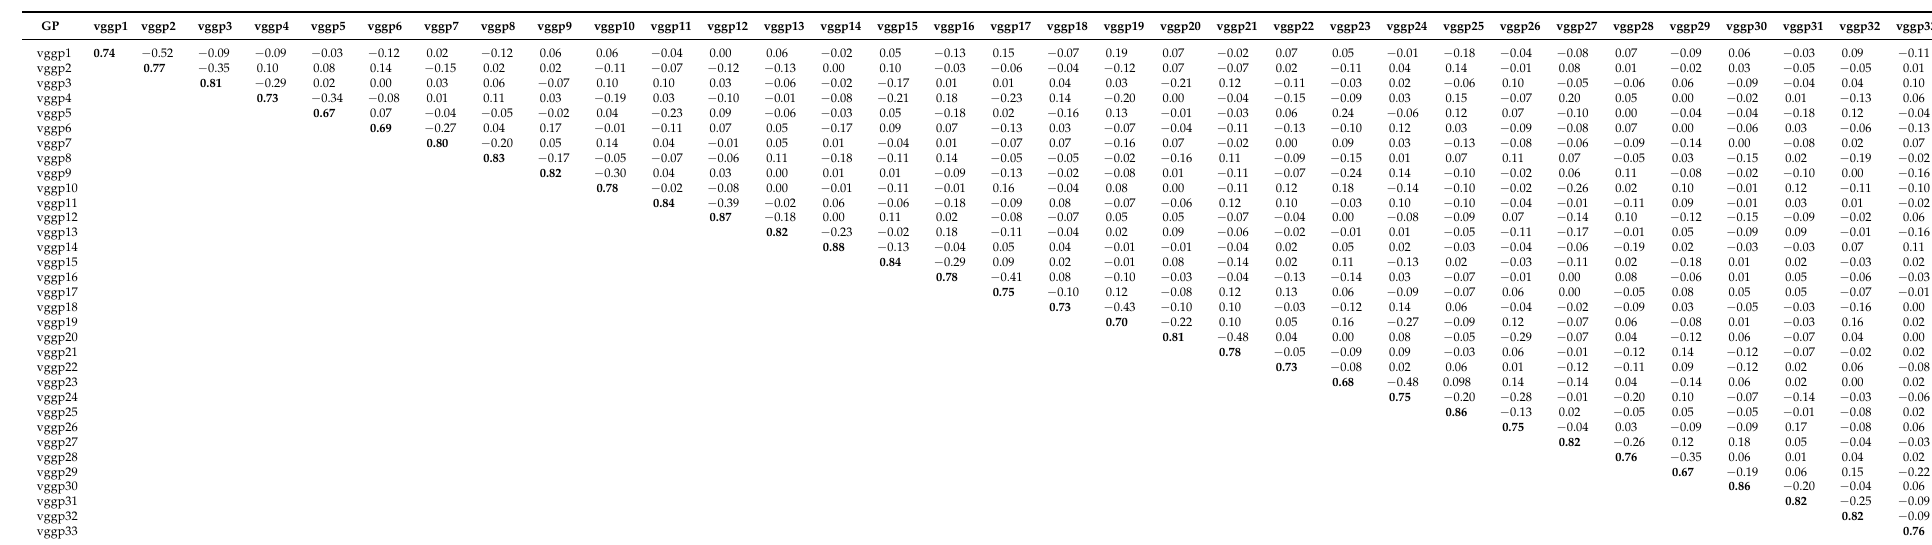
Table 4. Anti-image